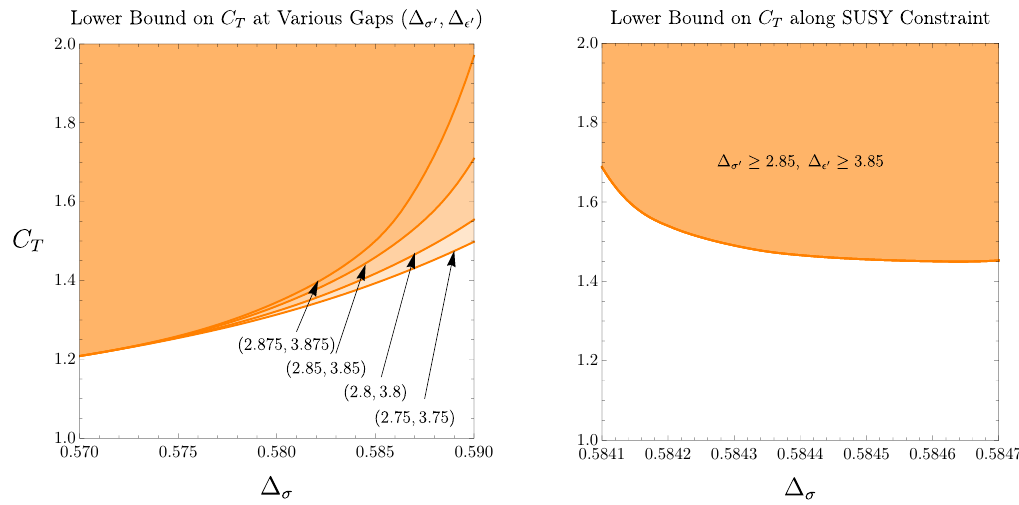
Figure 4 . (Left) A plot of the lower bound on the central charge C T versus (cid:1) (cid:27) , constrained to the SUSY line (cid:1) (cid:27) = (cid:1) (cid:15) (cid:0) 1 at gaps (cid:1) (cid:27) 0 = (cid:1) (cid:15) 0 (cid:0) 1 (cid:21) f 2 : 75 ; 2 : 80 ; 2 : 85 ; 2 : 875 g . (Right) The